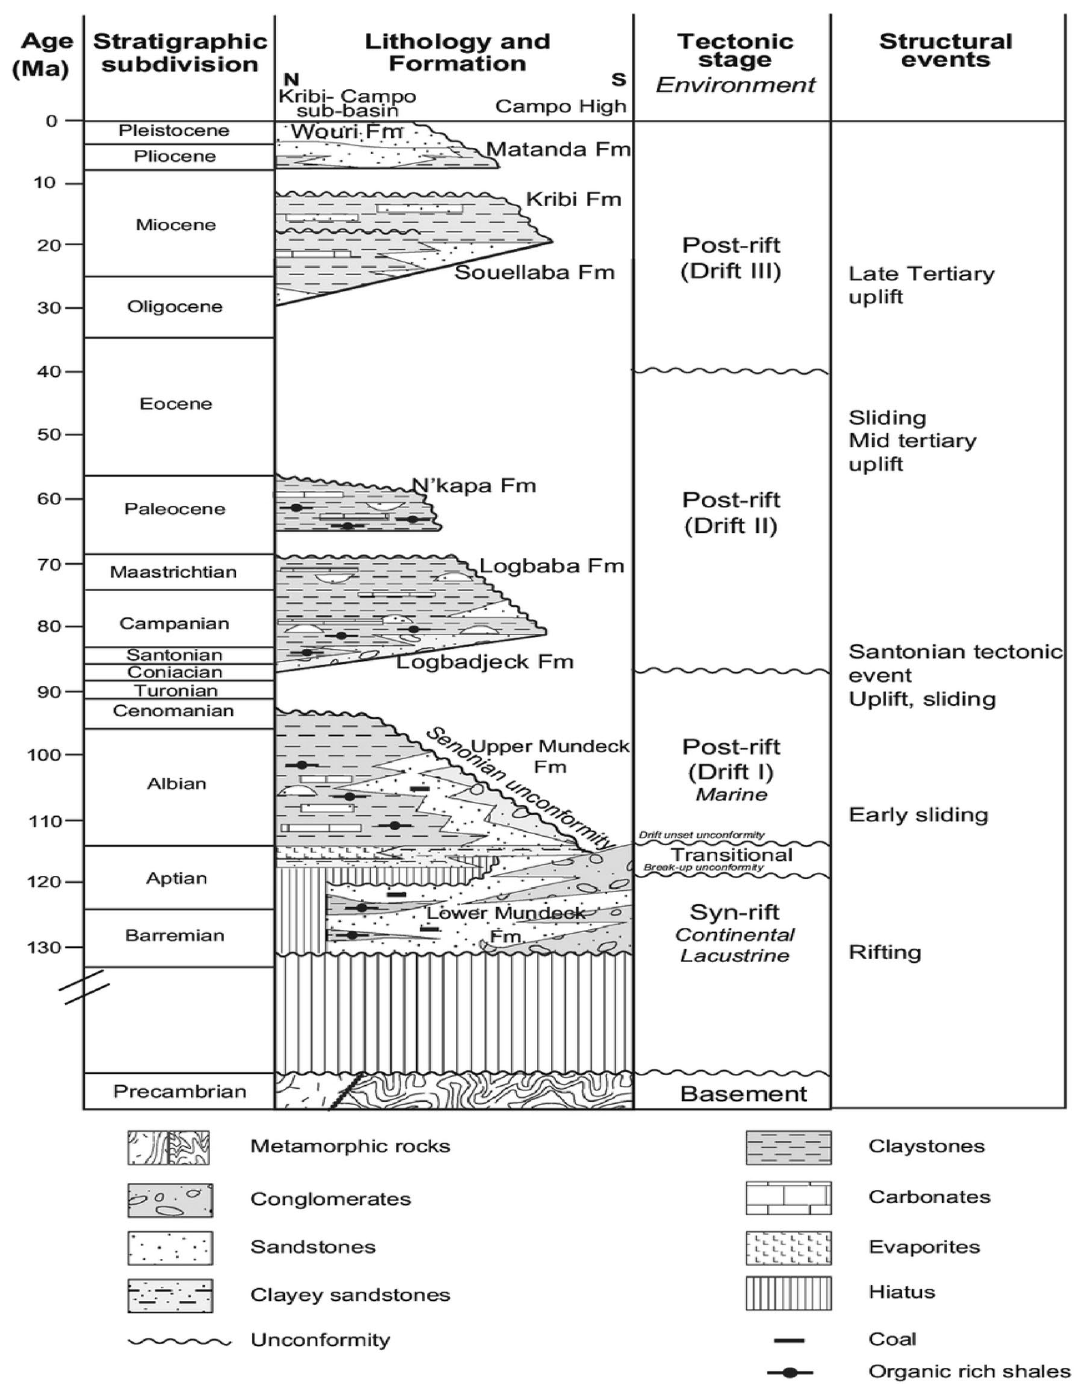
Fig. 2 Stratigraphy of the Douala Kribi Campo Basin adopted from Ntamak-Nida et al.